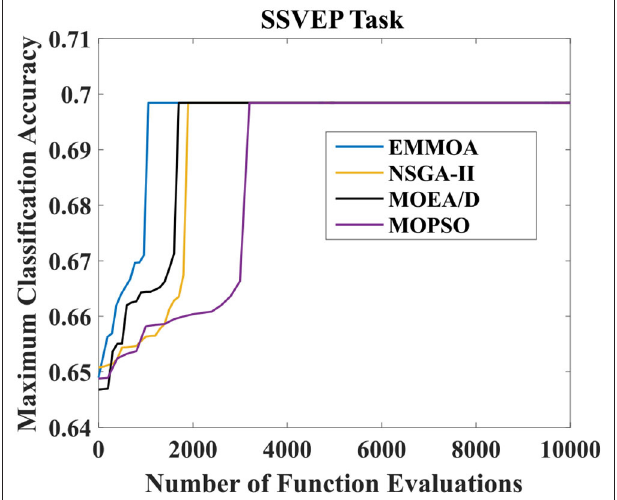
FIGURE 6 | Convergence of four algorithms for SSVEP task.